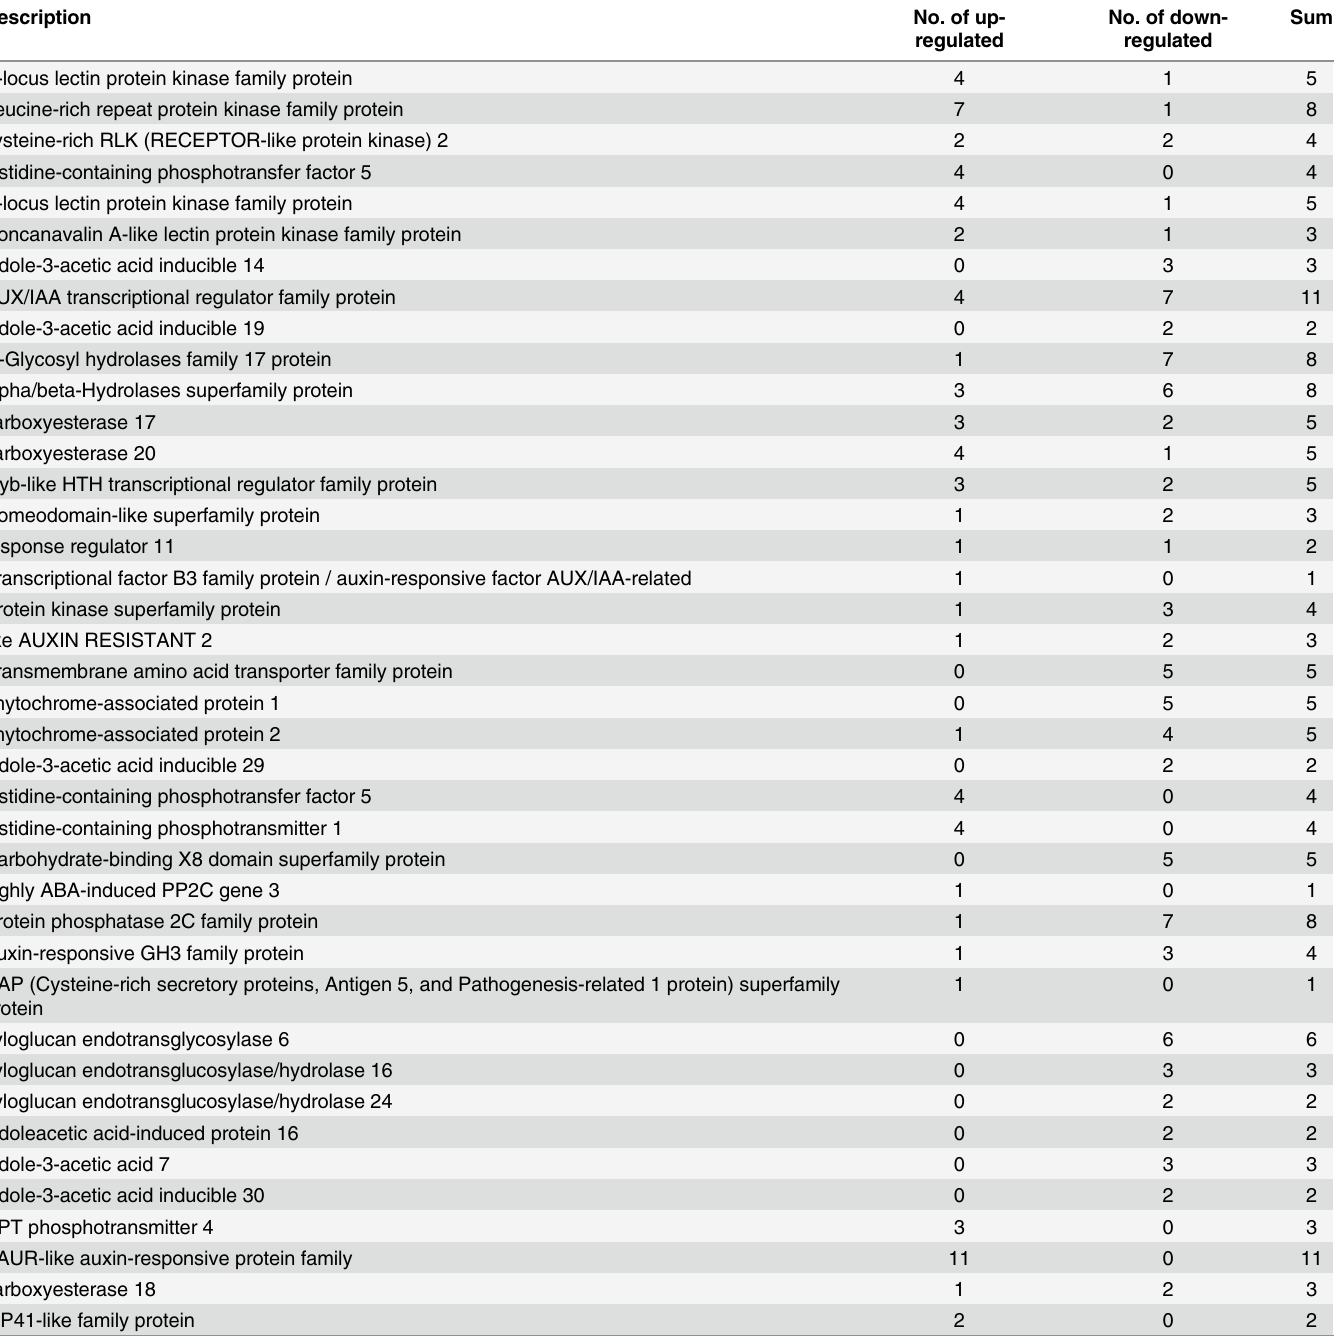
Table 5. Information of differential expression genes related to Plant hormone signal transduction pathways at developmental stages.